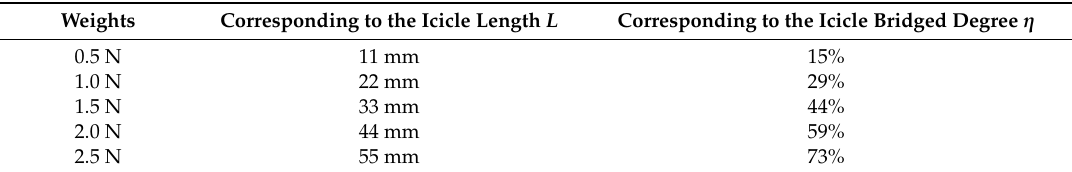
Table 2. Icicle load corresponds to the icicle length and icicle bridged degree with density of 0.9 g / cm 3 [36,37].